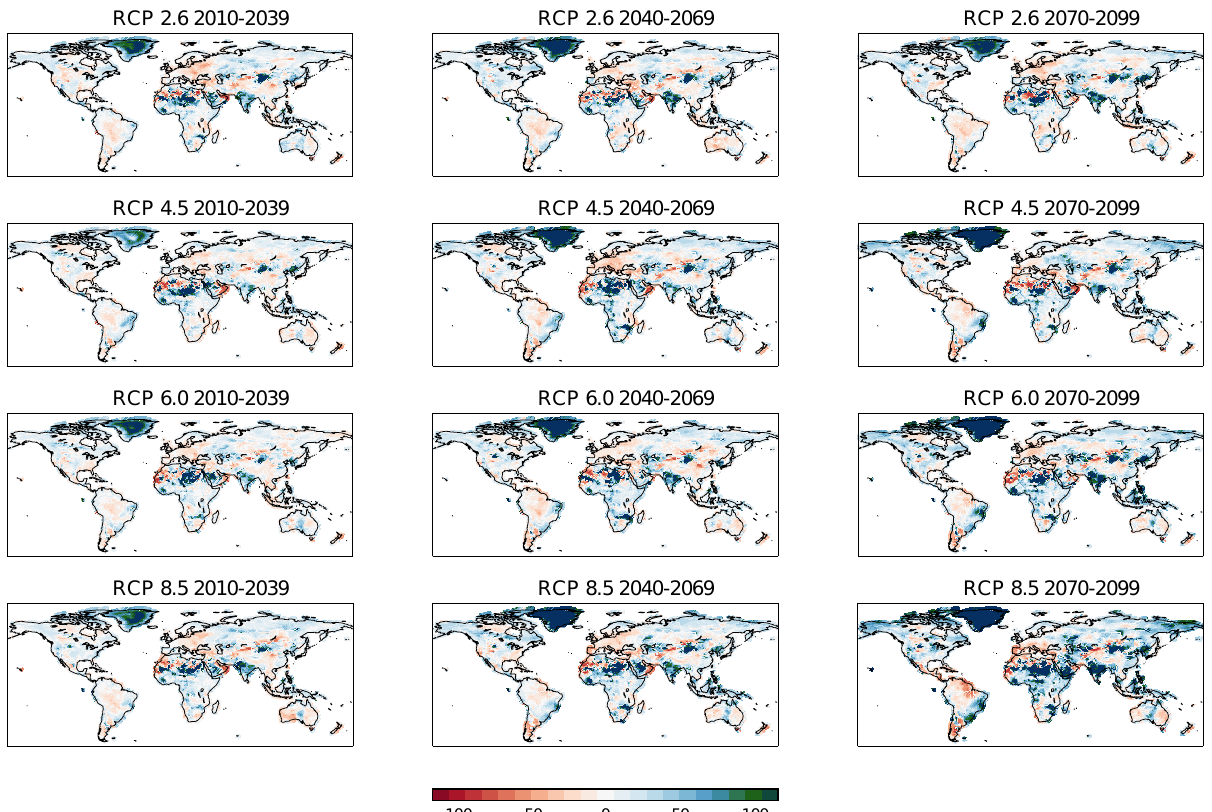
Figure 19. Percentage change in catchment river discharge simulated by HadGEM2-ES for 30-year means relative to 1971–2000 for the 4 RCP